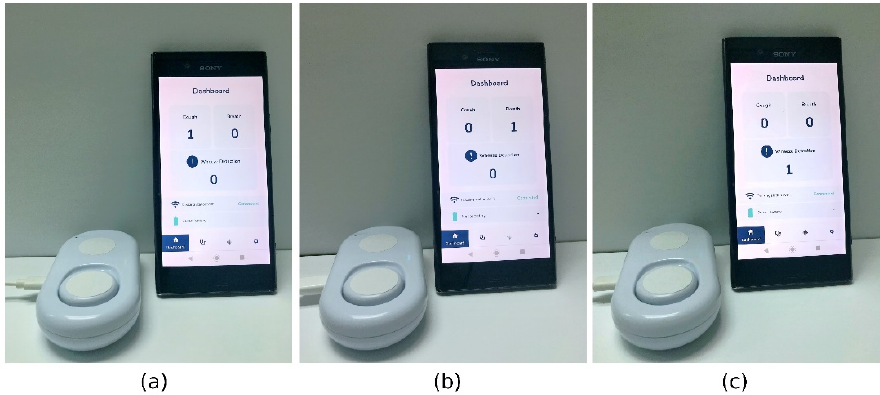
Figure 6. K-MDC classification of ( a ) cough, ( b ) breath, and ( c ) wheeze running in an IoT environment using the Renesas.